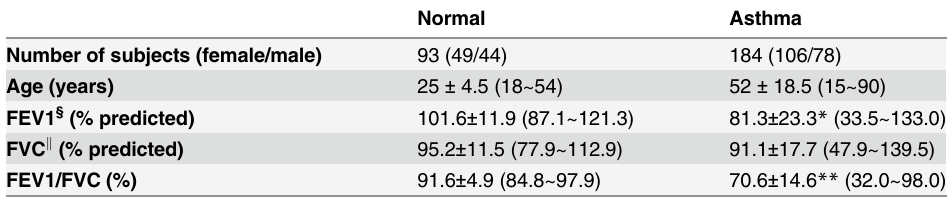
Table 1. Patient